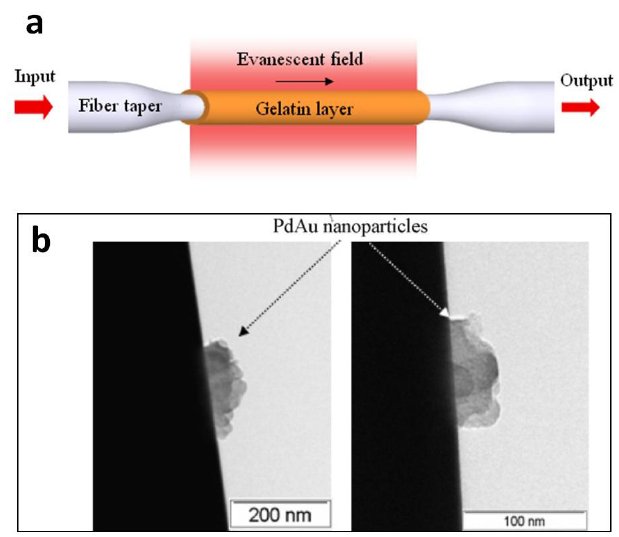
Figure 16. Functionally activated silica microfibers. ( a ) Schematic illustration of a gelatin coated microfiber for RH sensing [84]; ( b ) TEM images of microfibers (black cylinder) decorated with PdAu nanoparticles for hydrogen sensing [85].